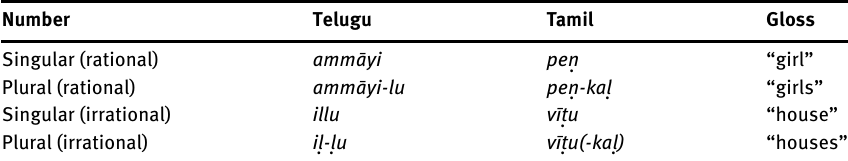
Table 1: Number Marking in Nouns. Number Telugu Tamil Singular (rational) amm¯ayi